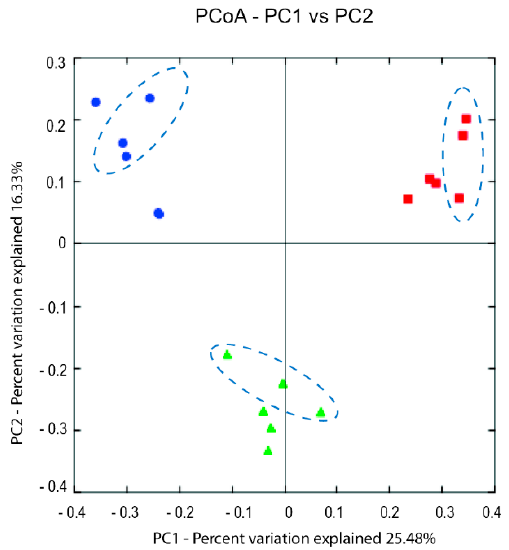
Figure 6. PCoA (Principal coordinate analysis) plot visualizing the unweighted UniFrac diversity between samples collected day 91 from the three producers: 1; red squared shapes, 2; blue round shapes, 3; green delta shapes. The encircled data points represents samples collected from the second year. PC1 and PC2, principal component 1 and 2, respectively.